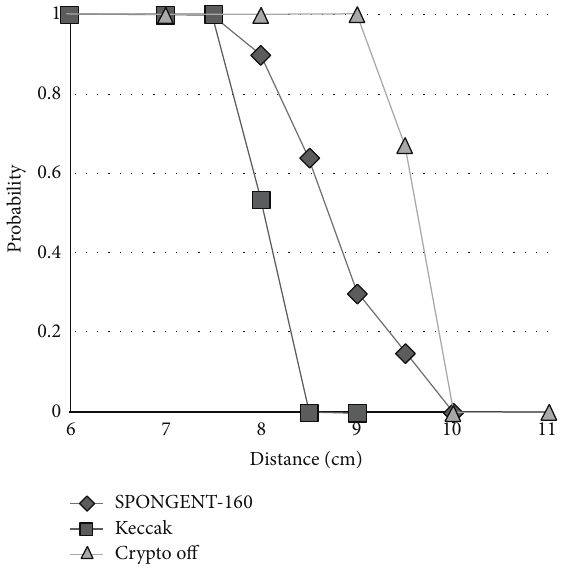
Figure 6: The communication distance between the tag and a